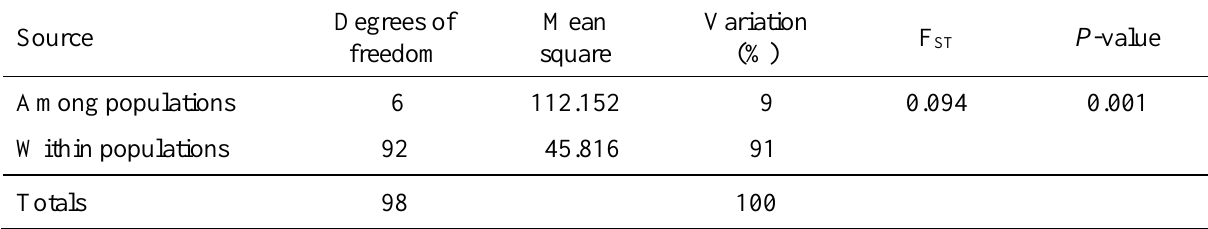
Table 3. Analysis of molecular variance (AMOVA) for the seven populations of Dyera polyphylla . F = genetic differentiation among populations. ST